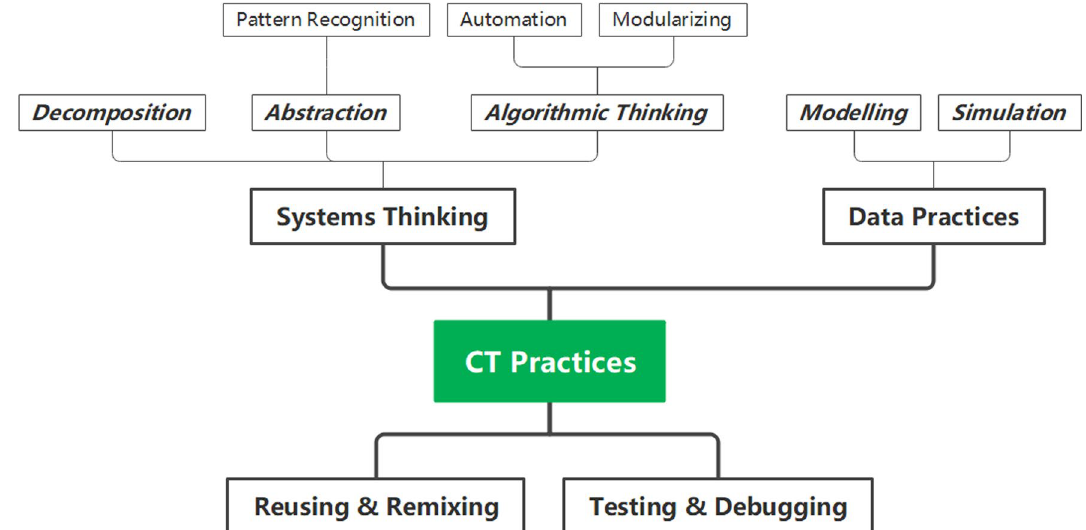
Fig. 6 Hierarchal relationship of computational practices in CT‑based mathematics